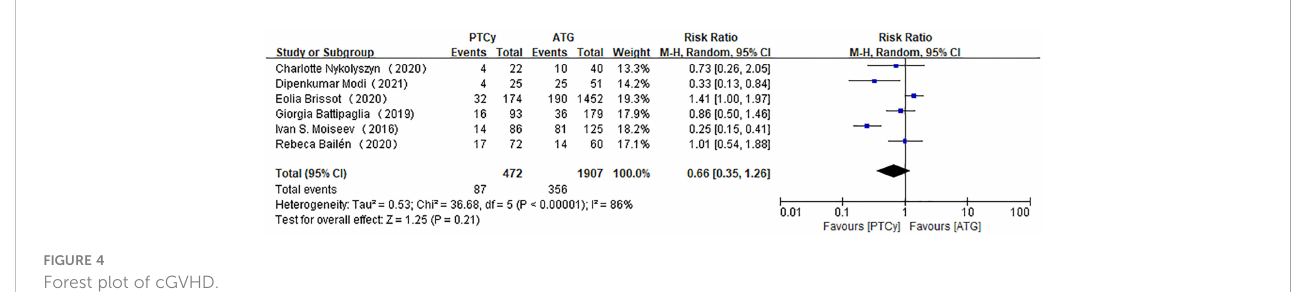
FIGURE 4 Forest plot of